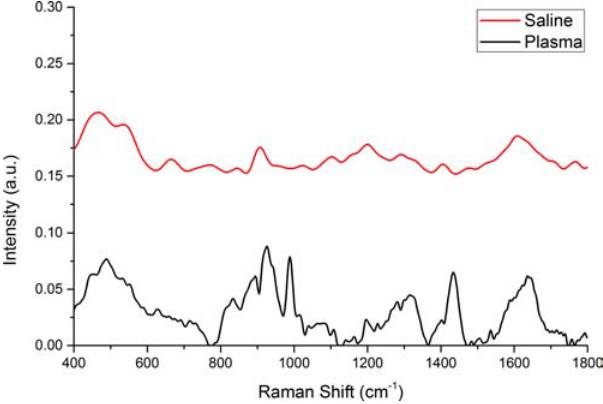
Fig. 8. Comparison of Raman spectra of blood plasma and